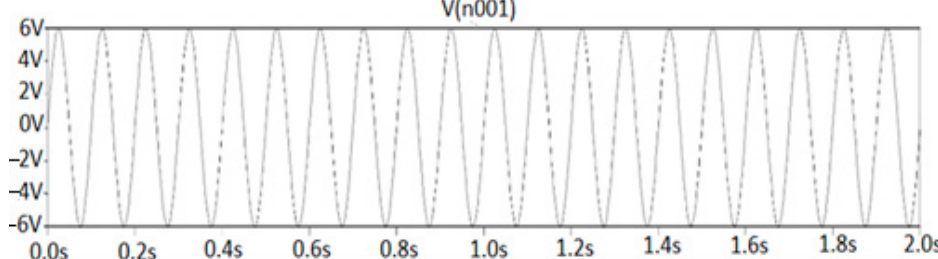
Figure 4. Trace analysis of the input voltage set at 6 V to initiate a charge.